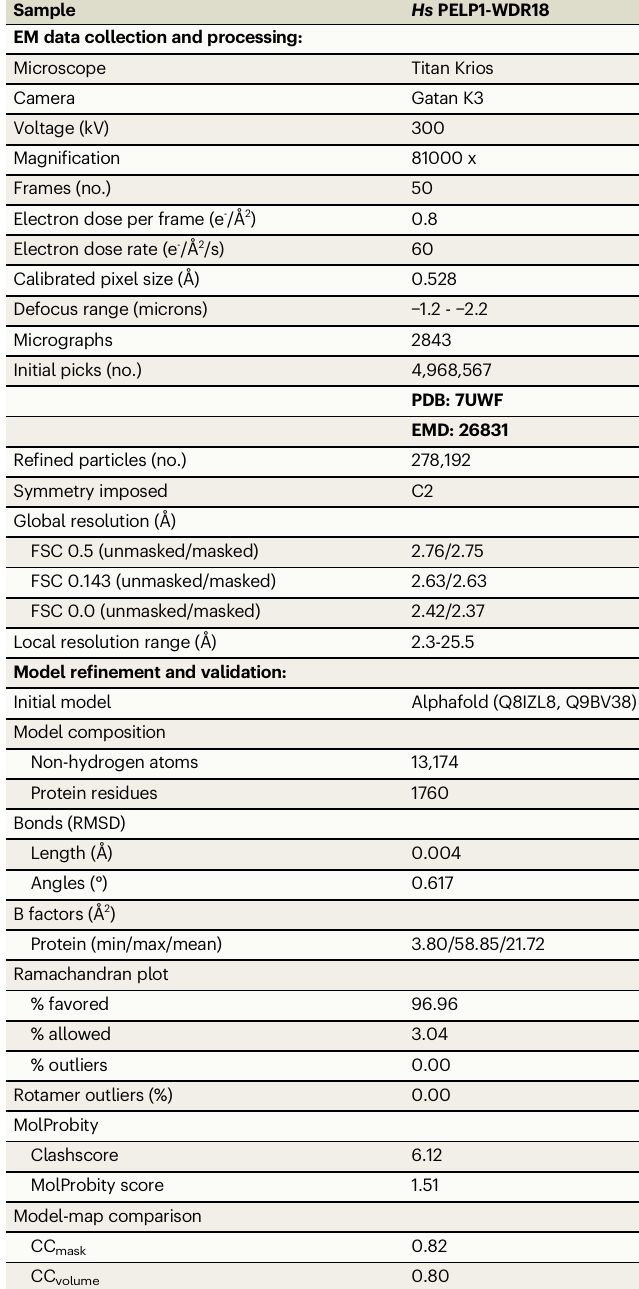
Table 1 | Cryo-EM data collection, re fi nement, and validation